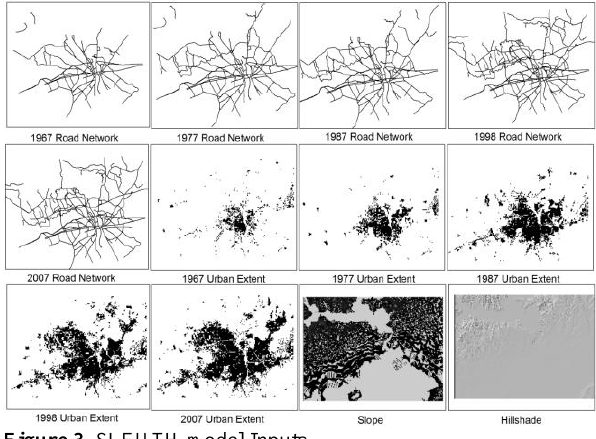
Figure 3. SLEUTH model